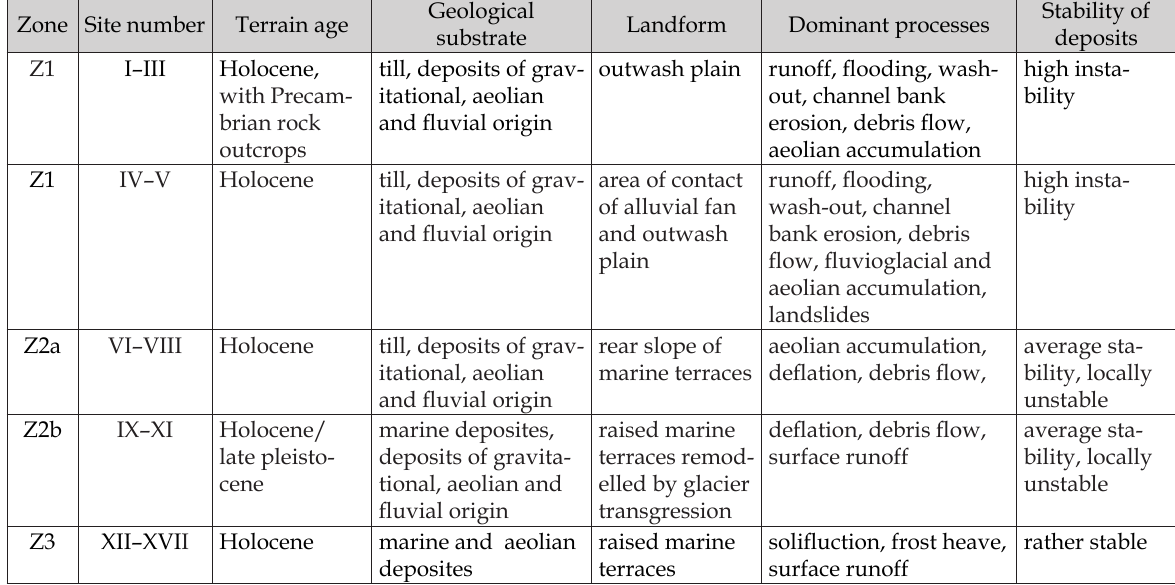
Table 1. Physical environment of delimited zones in Ebba